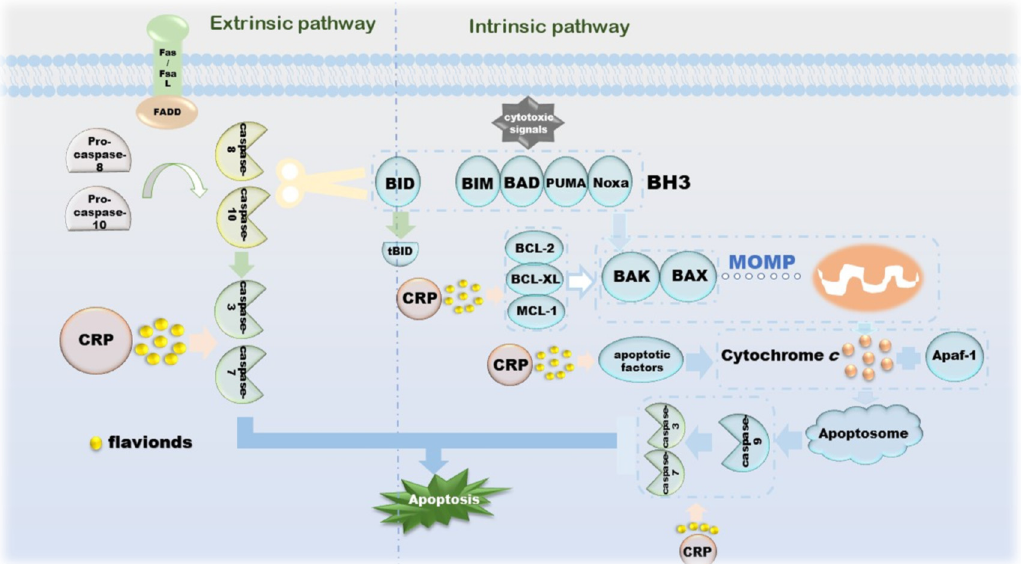
Figure 4. The mechanism of CRP promoting apoptosis of cancer cells.